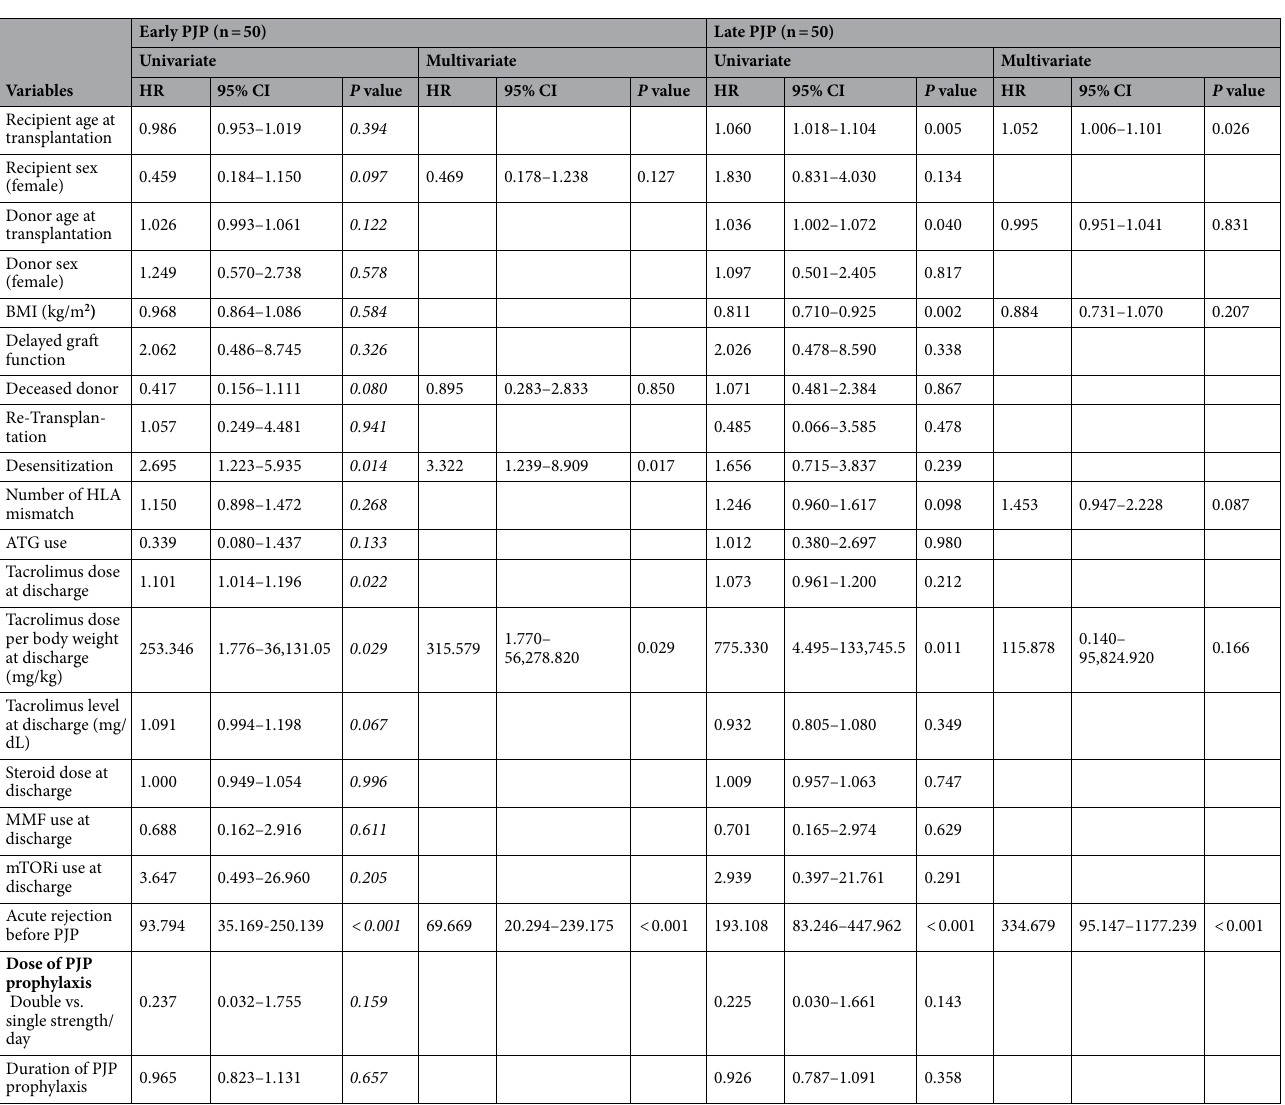
Table 5. Risk factors for early and late Pneumocystis jirovecii pneumonia after kidney transplantation. Multivariate analysis was performed using variables that showed significance of P < 0.10 in univariate analysis. Abbreviations: ATG, anti-thymocyte globulin; BMI, body mass index; CI, confidence interval; HR, hazard ratio; MMF, mycophenolate mofetil; mTORi, mammalian target of rapamycin inhibitor; PJP,